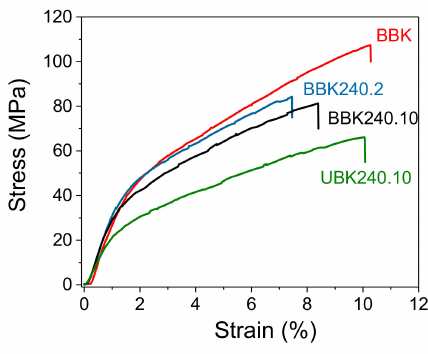
Figure 4. Representative stress-strain curves of films made from TEMPO-oxidized CNF. Sample names are the same as in Figures